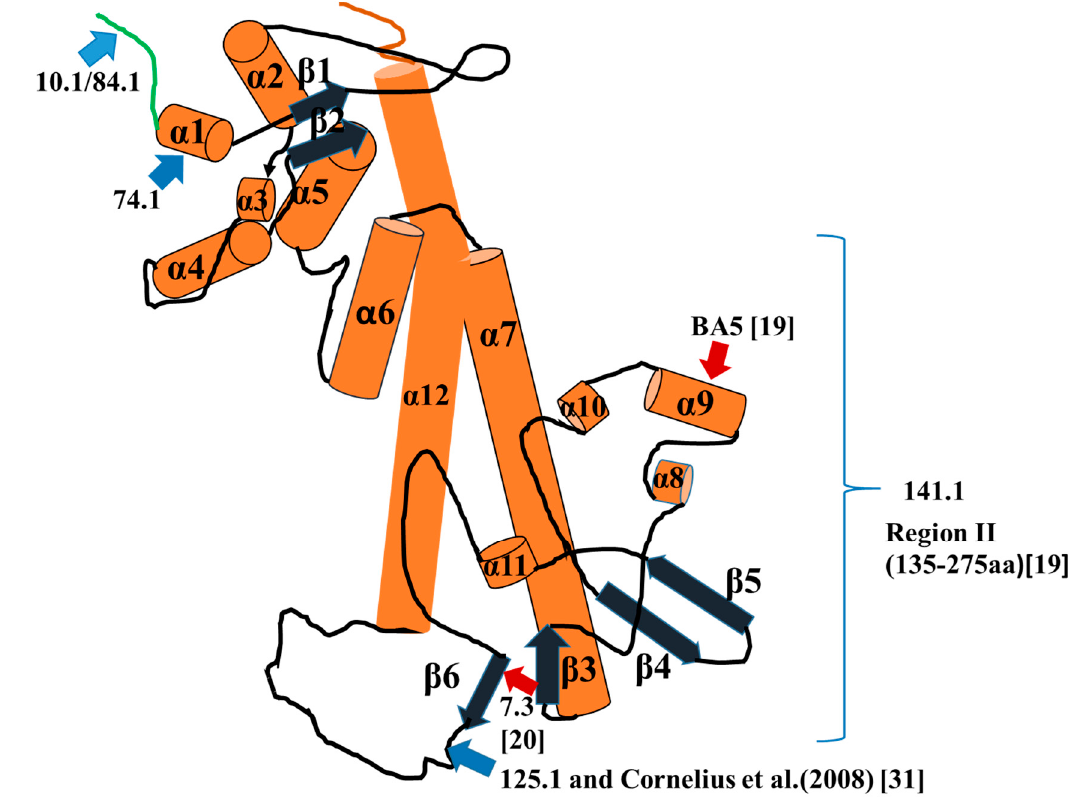
Figure 3. Schematic diagram of binding sites on the V-antigen. The structure of the V- antigen as shown is based on that reported by Derewenda et al. (2004) [30]. The orange tubular structures represent coiled-coil peptides, and the dark blue structures represent β -sheets with arrow heads pointing in the 5 ′ to 3 ′ -direction. The red arrows are pointing to reported or putative binding sites for mAb 7.3 [21] and BA5 [20]. The light blue arrows are pointing to the binding sites of mAbs (10.1/84.1, 74.1, and 125.1) from this report, except the binding site for 125.1 also represents that reported by Cornelius et al. (2008) [31] for polyclonal antibodies induced by a nonhuman primate and BALB/c mice by the wild-type V-antigen [31]. The amino-terminal end of the protein is colored green, while the C-terminal end is colored red. The conformational binding site of 141.1 is unknown but present on the 135–275 amino acid protein fragment or in designated region II of the V- antigen [19].